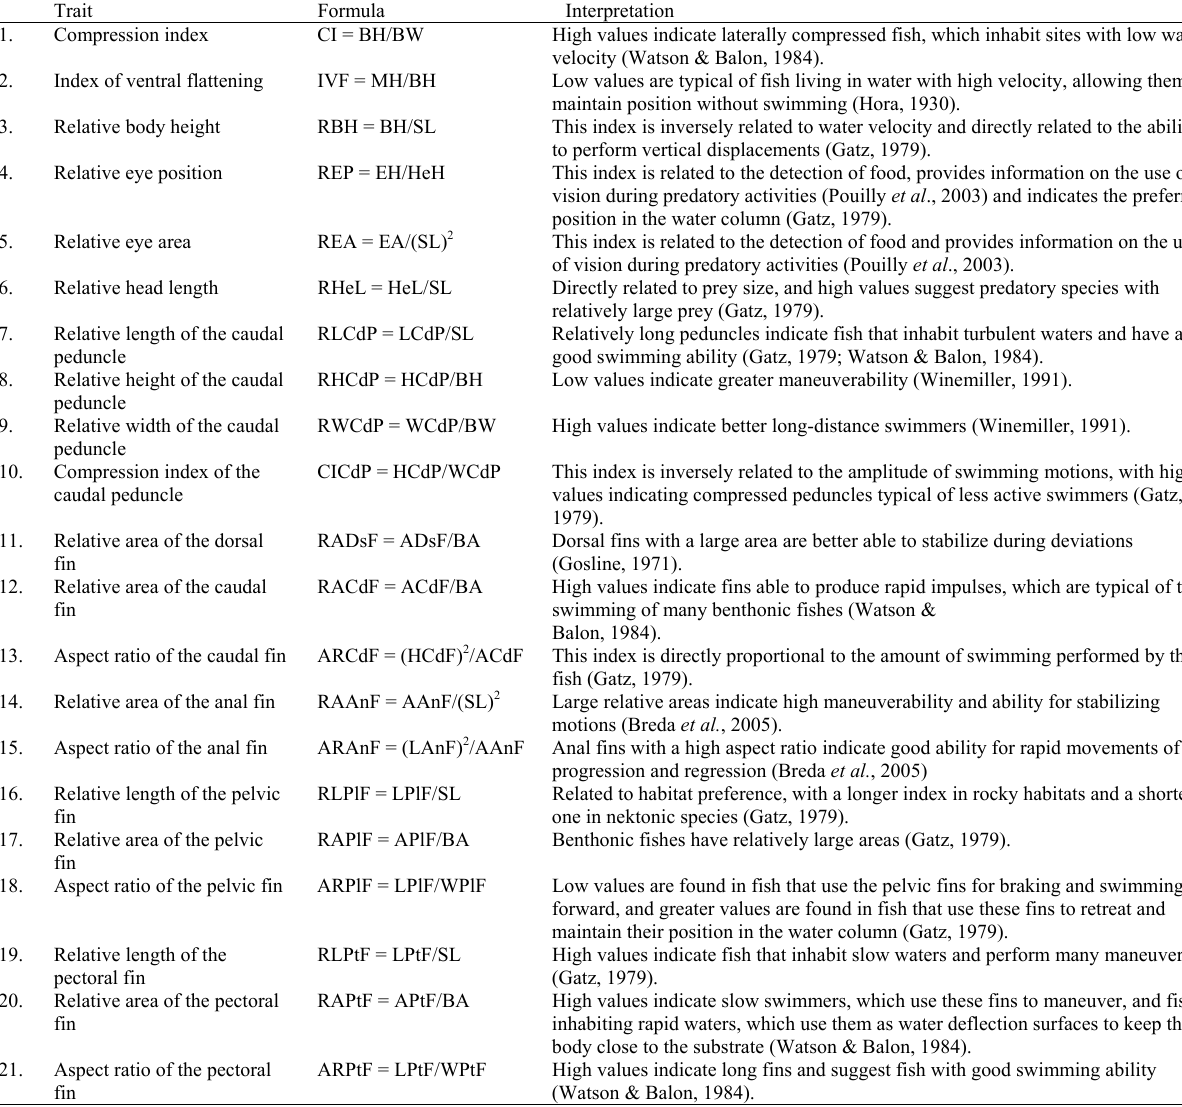
Table 2. Description of ecomorphological traits and their ecological significance